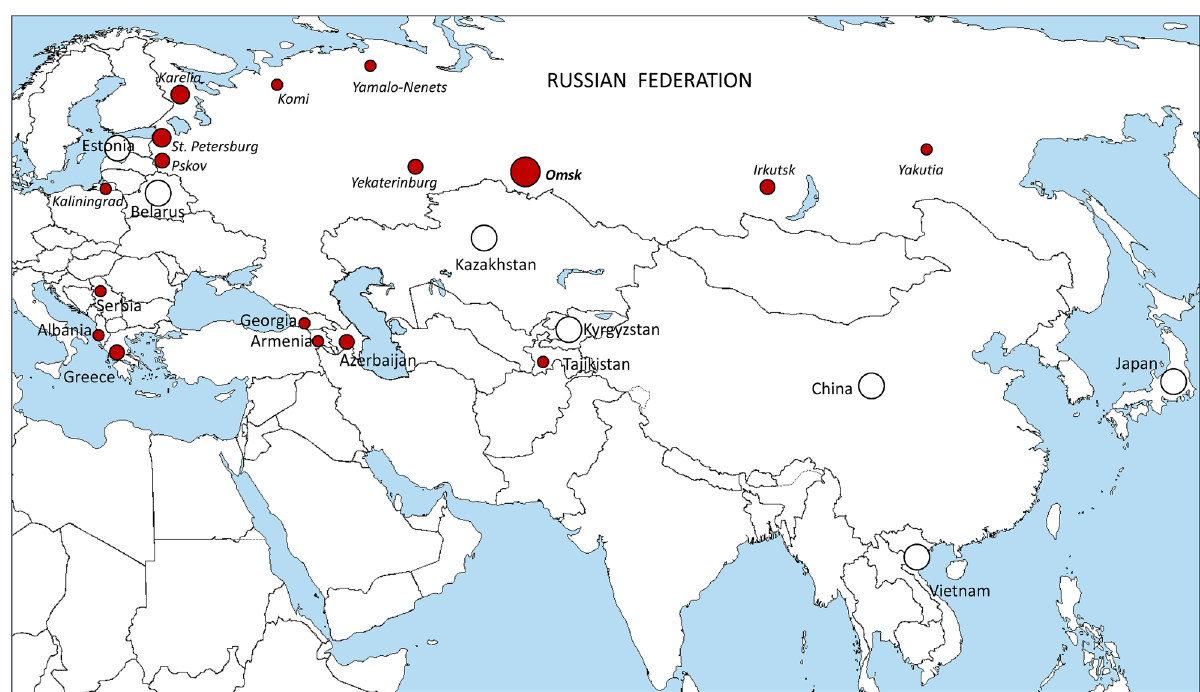
Figure 3. Geographic distribution of the Beijing 1071-32-cluster isolates identified in this study. Circle size roughly correlates with the proportion of identified isolates of this cluster (the smallest dots depict single isolates). Absence of these isolates in the local populations is shown by white circle. No Beijing 1071-312-cluster isolates were detected in Brazil (not shown on the map), Free map: https:// commo ns. wikim edia. org/ wiki/ File:A_ large_ blank_ world_ map_ with_ oceans_ marked_ in_ blue.